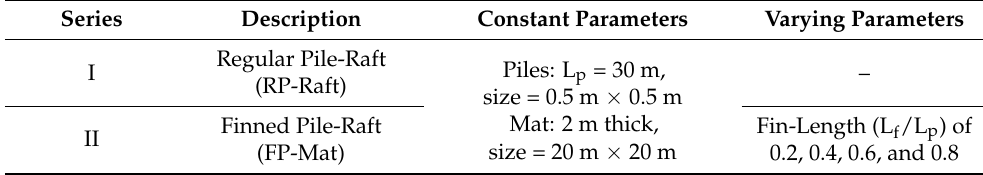
Table 3. Numerical analyses program of the present SSI